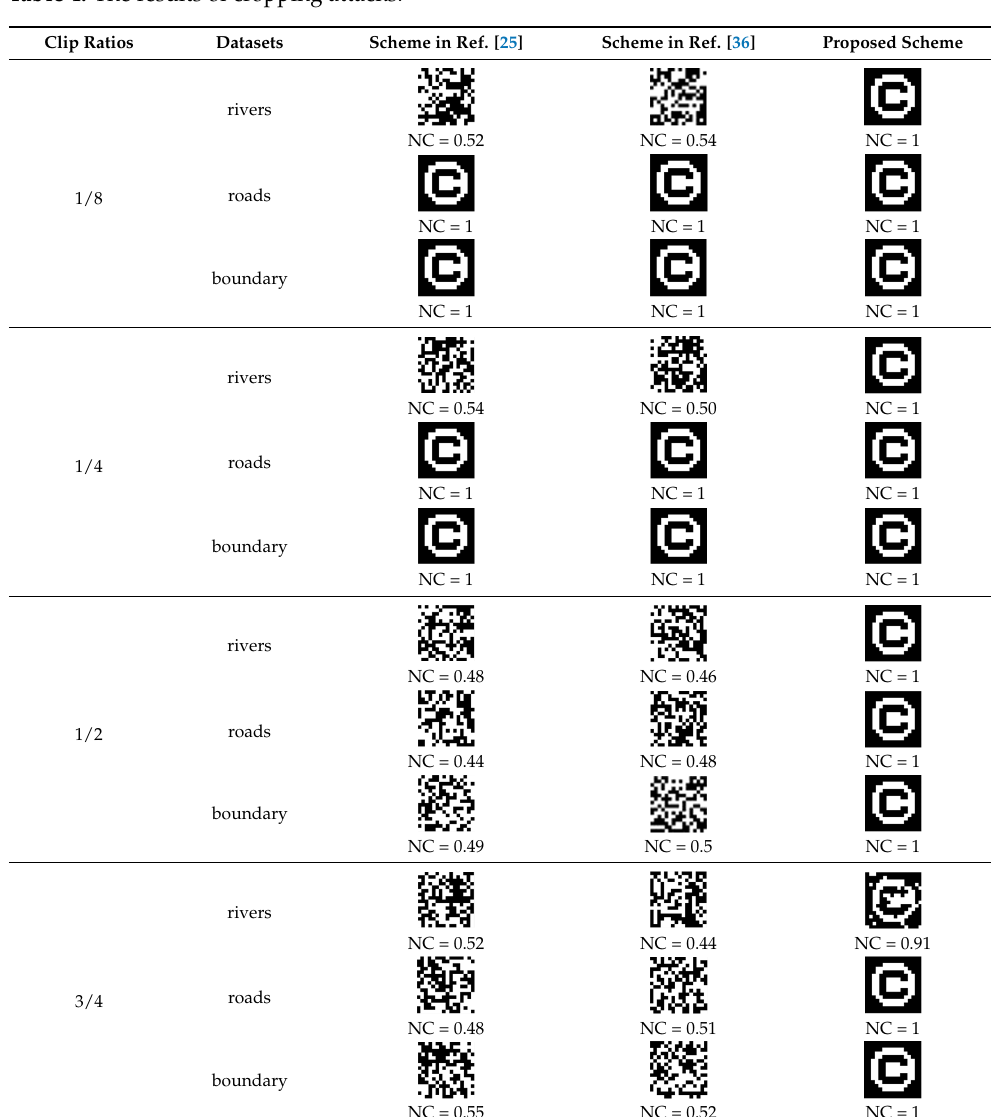
Figure 11. The results of deletion attacks.